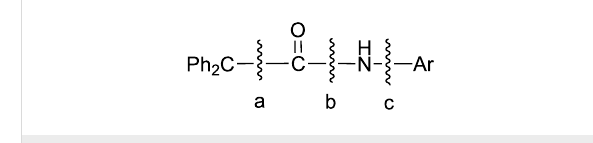
Scheme 4: Anodic bond cleavages in amides of type Ph 2 CHCONHAr.